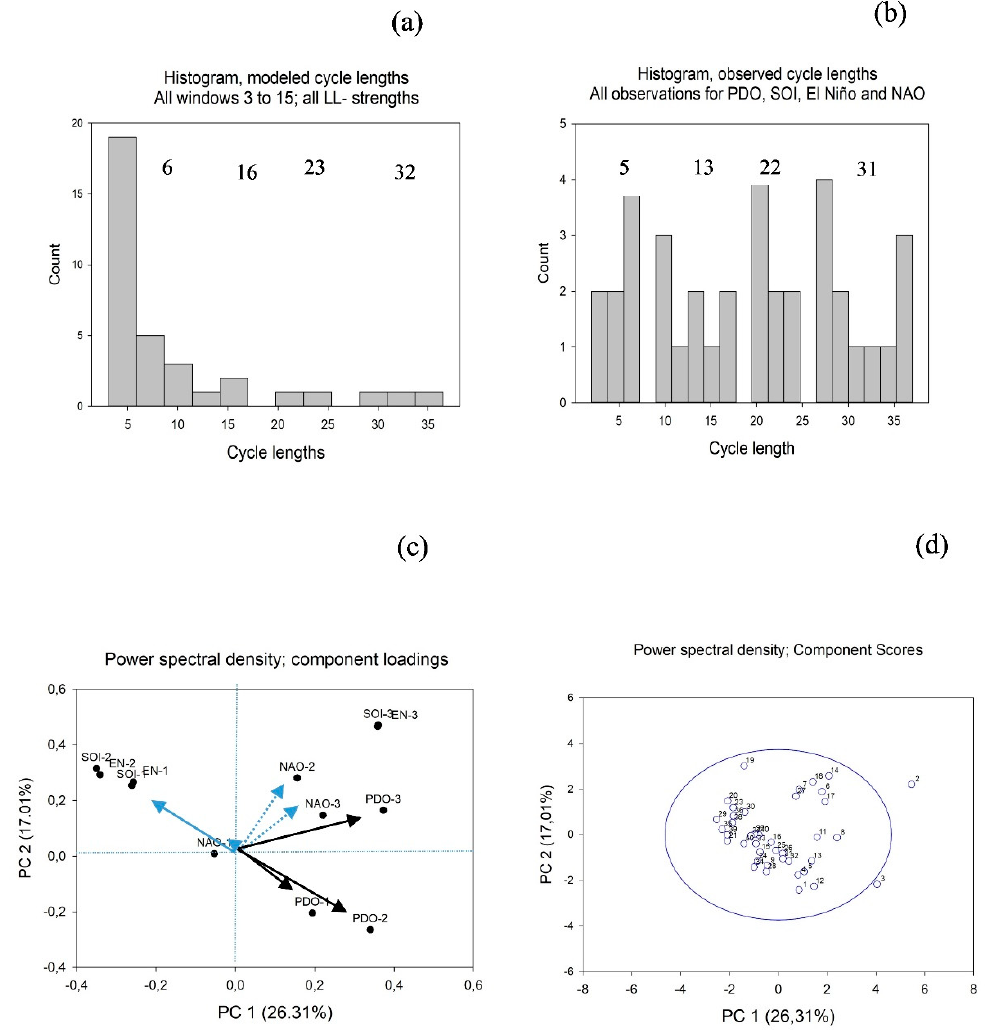
Figure 5. Power spectral densities. ( a ) Histogram for modeled cycle lengths, windows 3 to 15 and all LL strengths (see text). ( b ) Histogram for all observed cycle lengths identified for the four ocean oscillations, PDO, SOI, El Niño, and NAO. ( c ) Component loadings for power spectral density (PSD) of the four time series for PDO, SOI, El Niño, and NAO and for eight sub-series. 1 = full series, 2 = beginning to 1949; 3 = 1950 to end. ( d ) Component scores for the PSD sets in ( c ).